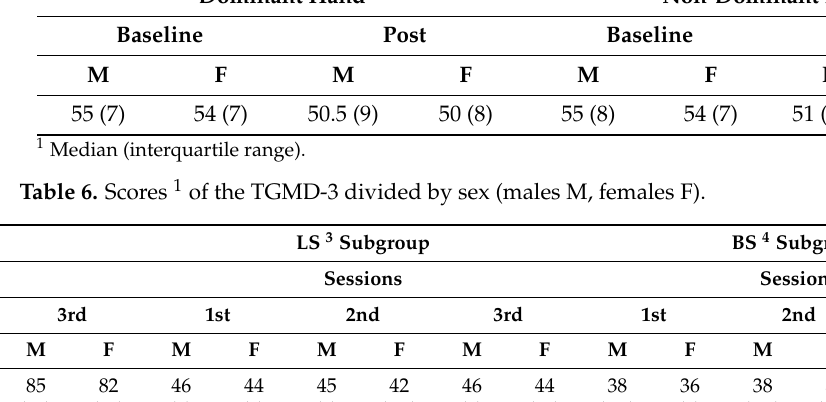
Table 5. Scores 1 of the BBT divided by sex (males M, females F). Dominant Hand